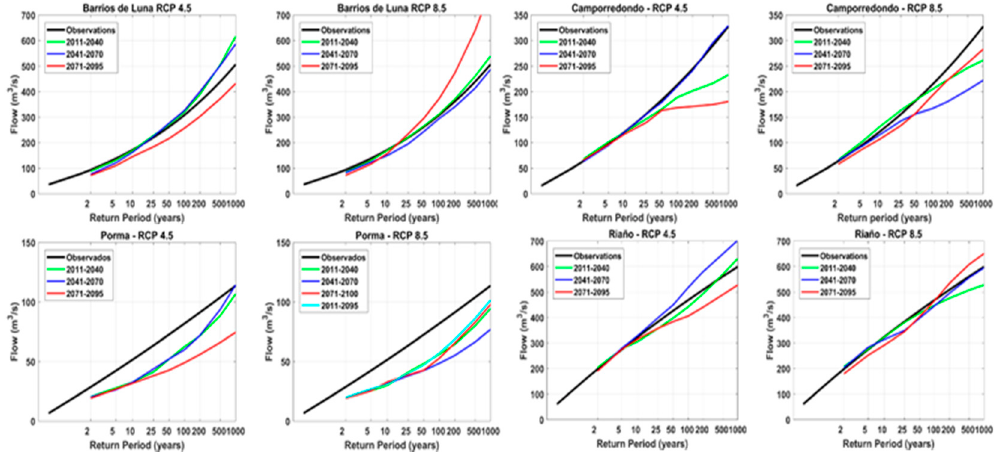
Figure 5. Flood frequency curves in the future period (2011–2095) with the best bias correction techniques referred to in the previous